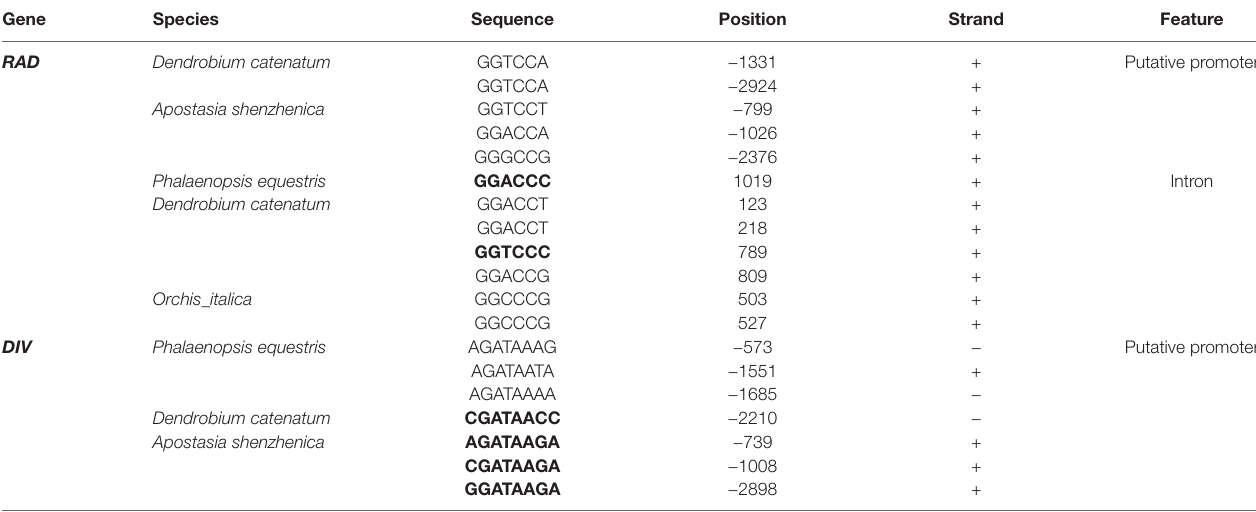
TABLE 1 | Predicted binding sites of CYC (5 ′ -GGNCCC-3 ′ ) and DIV (5 ′ -VGATAMSV-3 ′ ) of Antirrhinum majus in the putative promoter and intron of RAD and in the putative promoter of DIV , respectively, in the orchids Phalaenopsis equestris , Dendrobium catenatum , and Apostasia shenzenica.